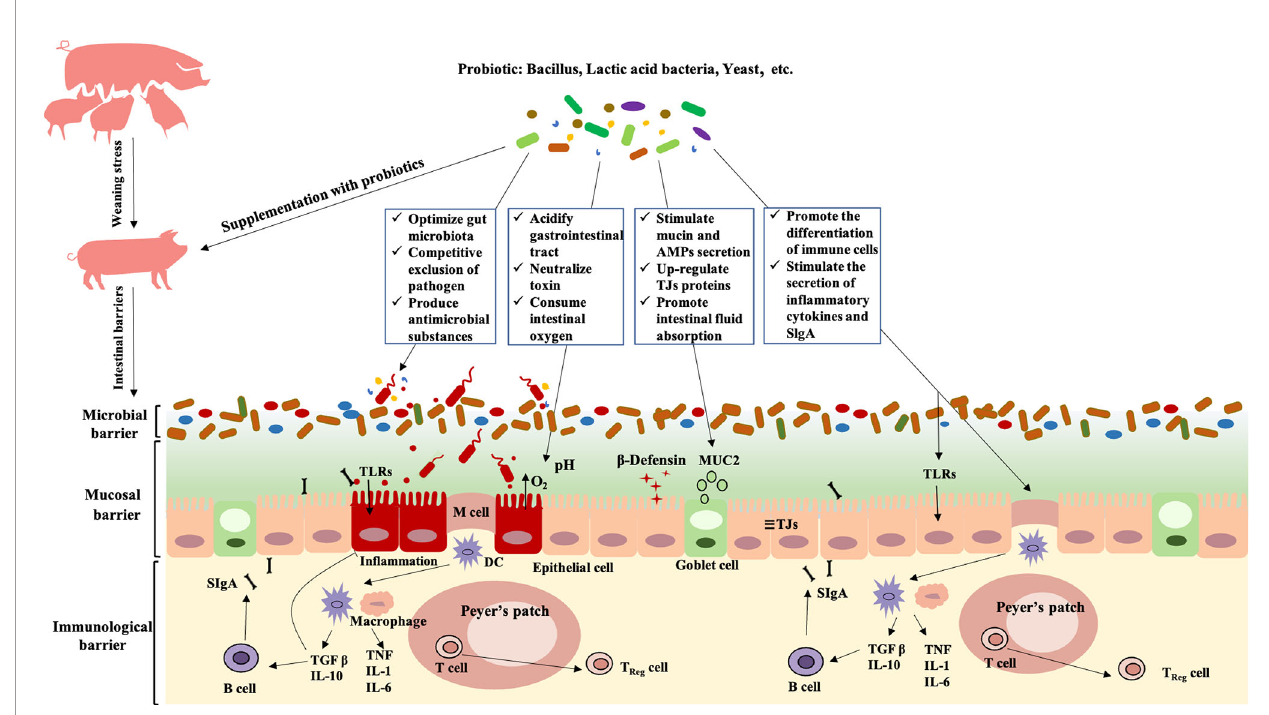
FIGURE 1 | Modulation of probiotics on intestinal barriers in postweaning diarrhea piglets. Probiotics relieve PWD by regulating the intestinal microbial barrier: 1) shaping the gut microbiota oriented by bene fi cial bacteria; 2) competitive exclusion of pathogen; 3) producing antimicrobial substance and neutralize toxin. Probiotics relieve PWD by regulating the intestinal mucosal barrier: 1) stimulating the secretion of mucin and antimicrobial peptides; 2) upregulation of intestinal tight junction protein expression; 3) maintaining normal intestinal permeability, and promoting intestinal fl uid absorption and secretion reduction. Probiotics relieve PWD by regulating the intestinal immunological barrier: 1) promoting the proliferation and differentiation of intestinal immune cell; 2) stimulating the secretion of in fl ammatory and SlgA. TLRs, Toll-like Receptors; MUC2, Mucin 2; TJs, Tight Junctions; DC, Dendritic Cell; TGF- b , Transforming growth factor- b ; TNF, Tumor Necrosis Factor); IL, Interleukin; SIgA, Secretory Immunoglobulin A; AMPs, antimicrobial